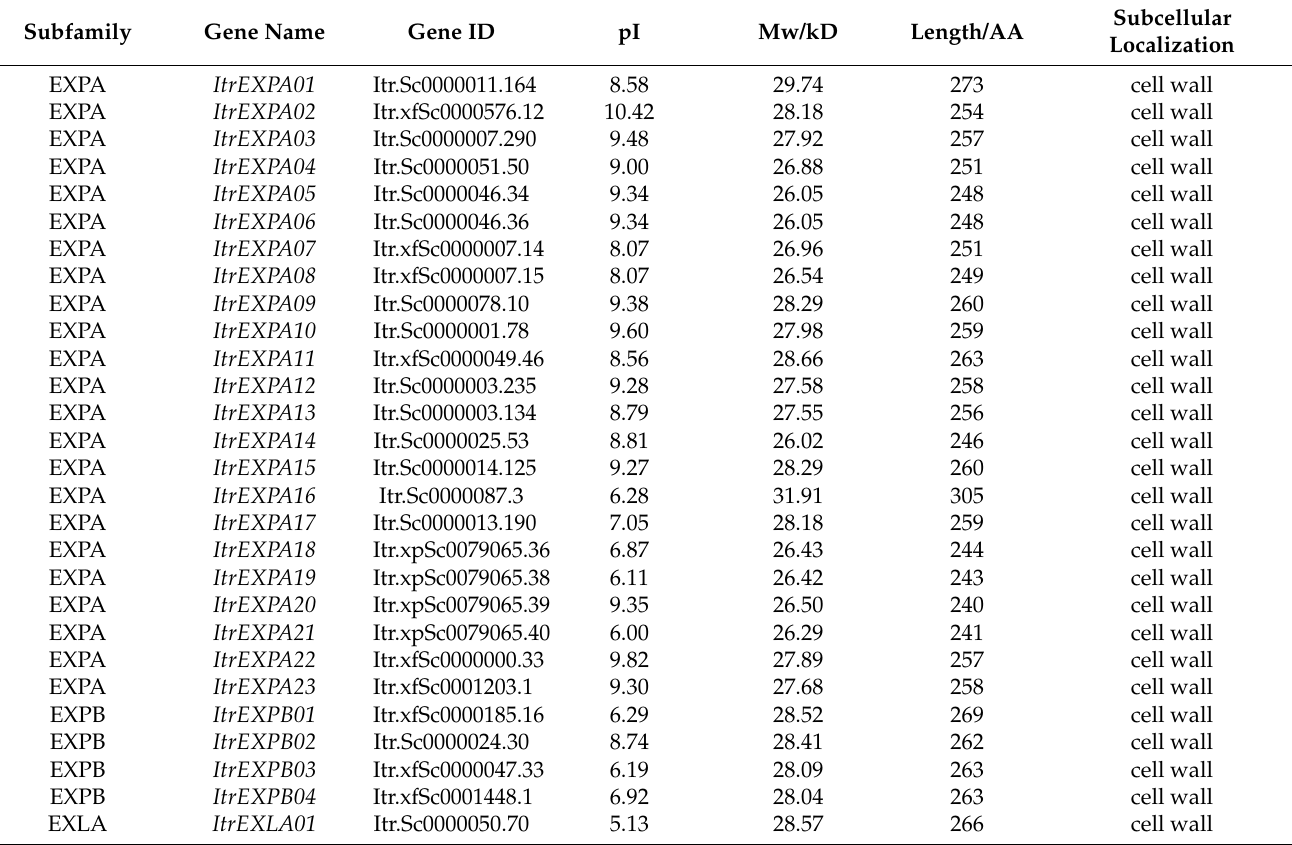
Table 1. Details of the 37 ItrEXPs in Y22